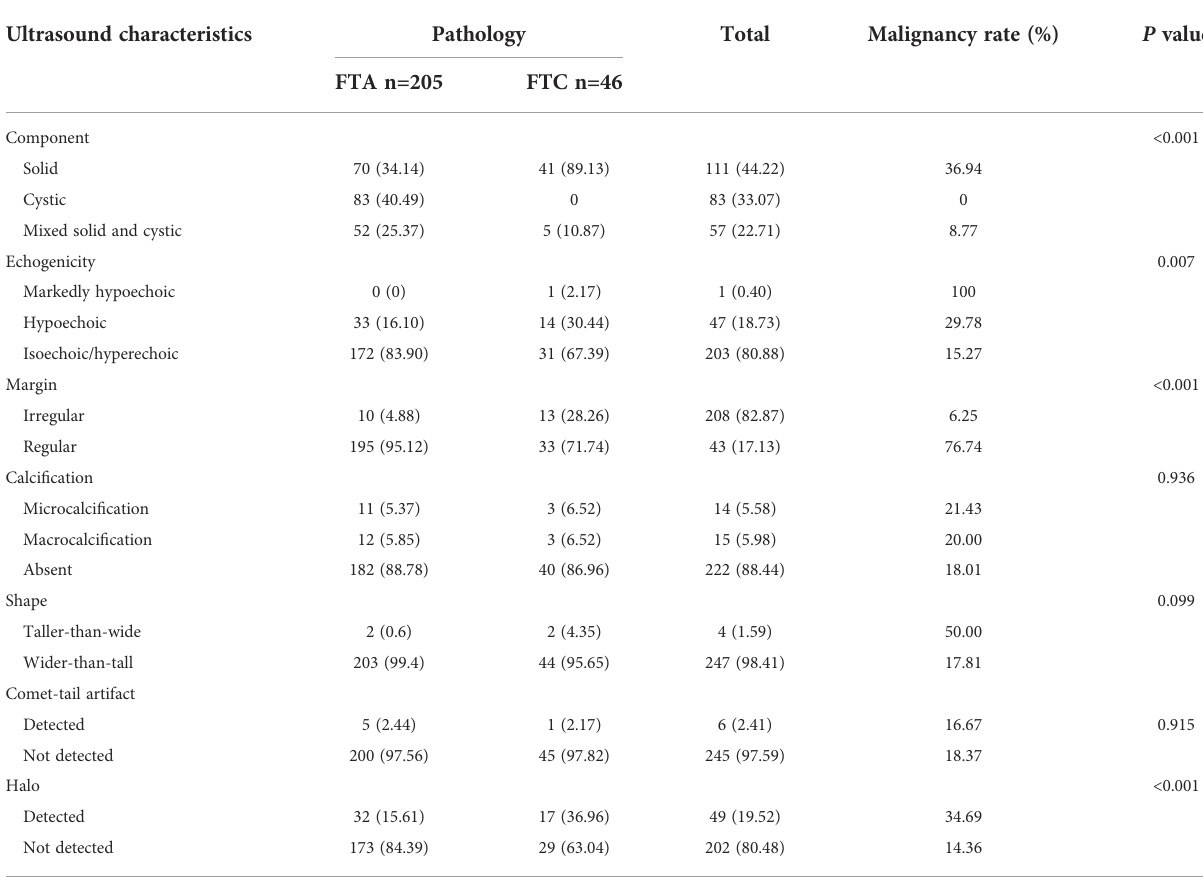
TABLE 2 Ultrasound characteristics of FTA and FTC, and the malignancy